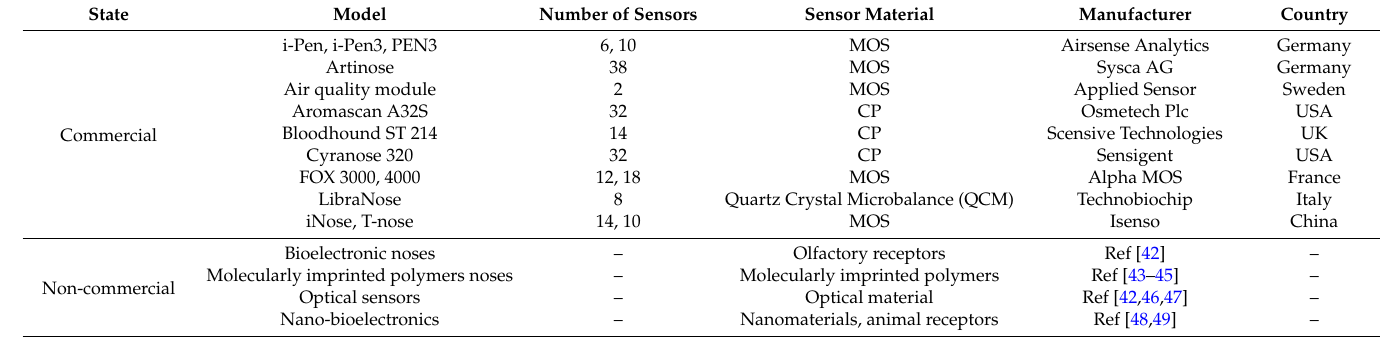
Table 1. E-nose models for commercial and non-commercial applications with different sensors such as Metal Oxide Sensor (MOS) and Conducting Polymer (CP).